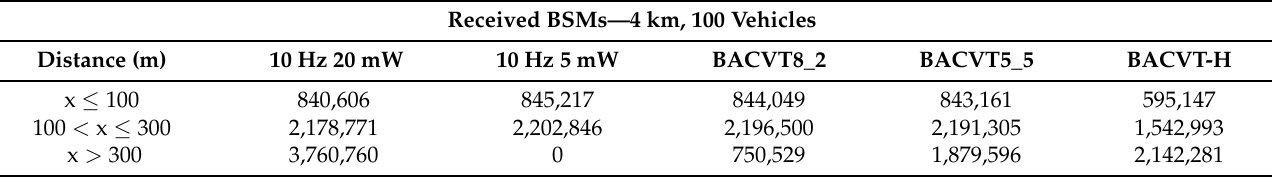
Table 3. Received BSMs in low vehicle